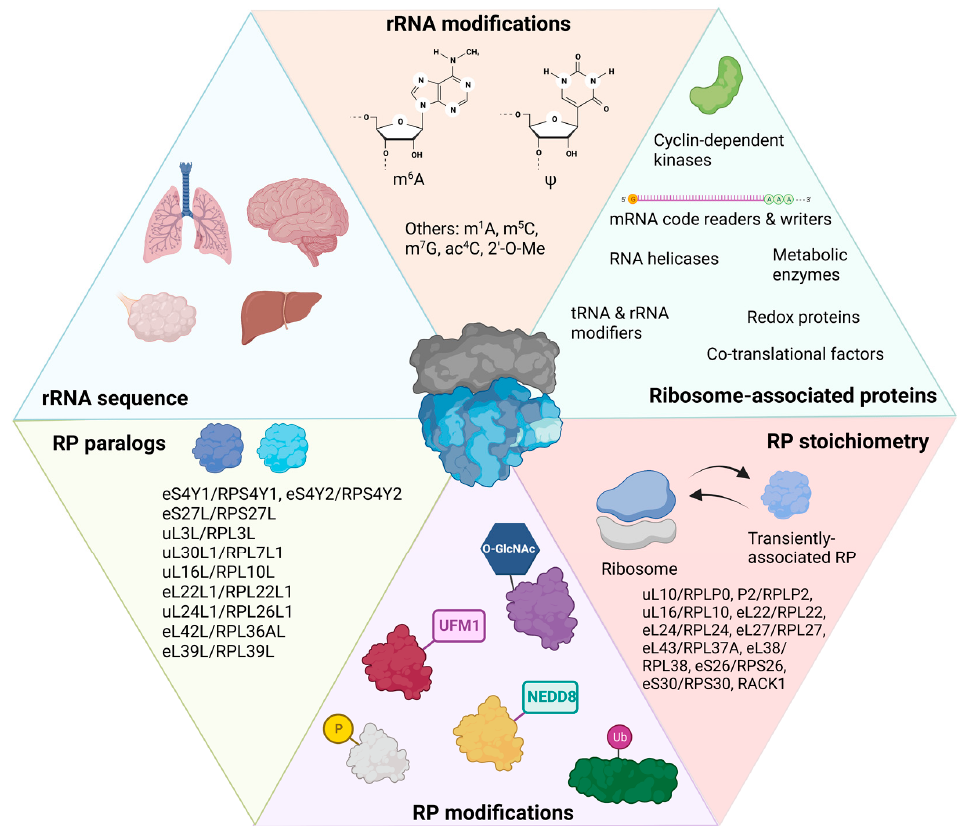
Figure 1. Ribosomal heterogeneity in mammals. Ribosomal RNA (rRNA) contains tissue-specific sequences (blue panel). There are several rRNA modifications, including N6-methyladenosine (m 6 A), N1-methyladenosine (m 1 A), pseudouridine ( Ψ ), 5-methylcyosine (m 5 C), N7-methylguanosine (m 7 G), N4-acetylation of cytosine (ac 4 C), and 2 ′ -O-methylation (2 ′ -O-Me) (orange panel). Multiple factors associate with ribosomes, altering their translational capacities (green panel). Ribosomal protein (RP) abundance can affect ribosome stoichiometry, and some RPs are known to be incorporated into ribosomes outside of canonical ribosome biogenesis in neurons (red panel). RPs can also contain several post-translational modifications: “P” is phosphorylation; “Ub” is ubiquitin protein; “UFM1” is ubiquitin-fold modifier 1 protein; “NEDD8” is neural precursor cell-expressed, developmentally down-regulated 8 protein, a Ub-like protein; and “O-GlcNAc” is O-linked β -N-acetylglucosamine (purple panel). Nine canonical RPs also have paralogous proteins, some of which are tissue specific (yellow panel). This figure was created with